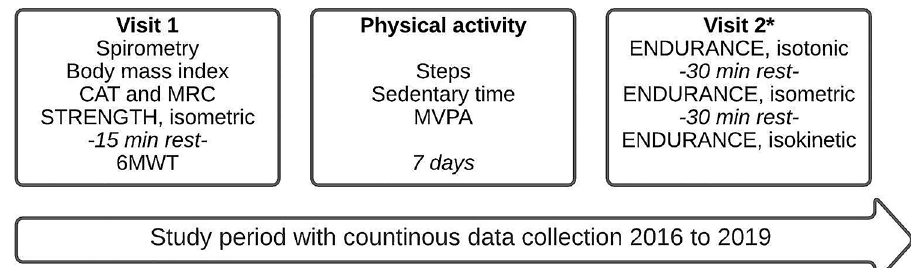
Figure 1. Description of study procedure. CAT COPD assessment test, MRC Medical Research Council dyspnea scale, 6MWT 6-minute walking test, MVPA time spent in moderate to very vigorous intensity. *Randomized order, POWER, was obtained from the isokinetic